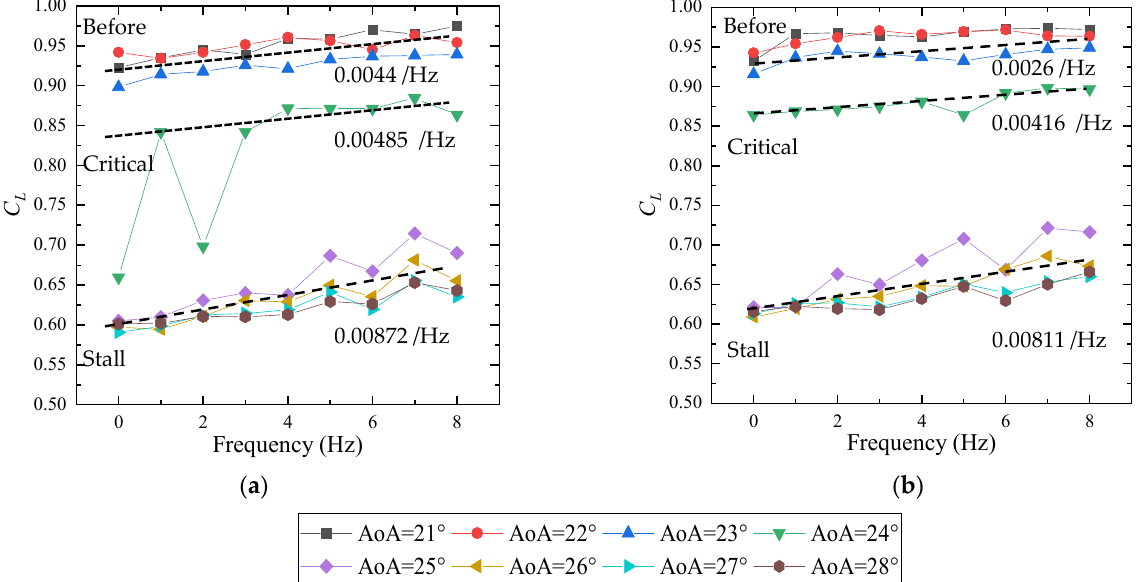
Figure 30. Lift coefficient versus frequency for different angles of attack (airspeed 10 m/s). ( a ) Vibra- tion amplitude of 4°. ( b ) Vibration amplitude of 6°.